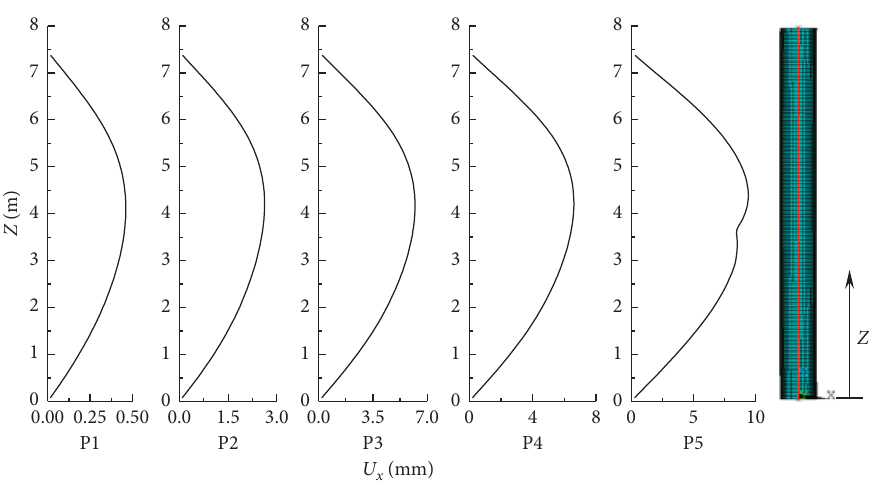
Figure 16: D610 × 8 ( λ � 35) deformation development under axial